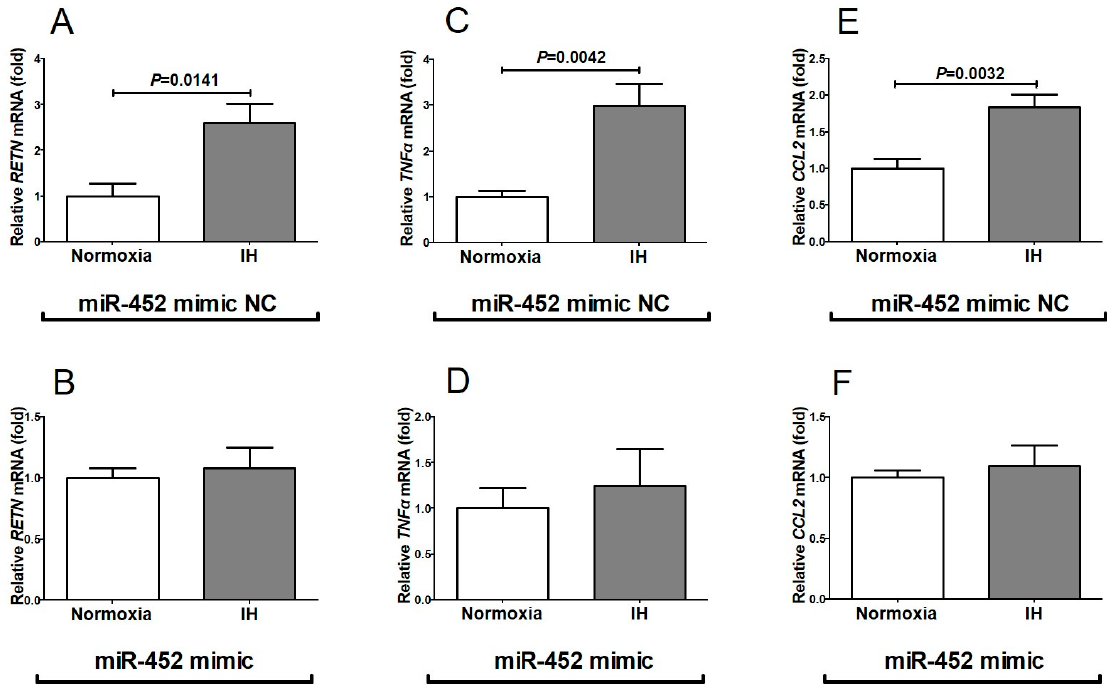
Figure 7. Effects of miR-452 mimic transfection on RETN , TNF α , and CCL2 expression. The miR-452 mimic (5 ′ -AACUGUUUGCAGAGGAAACUG-3 ′ , 5 ′ -GUUUCCUCUCUGCAAACAGUUUU-3 ′ ) and non-specific control RNA (miR-452 mimic NC) (5 ′ -UUCUCCGAACGUGUCACGUtt-3 ′ , 5 ′ -ACGUGACACGUUCGGAGAAtt-3 ′ ) were synthesized by Nihon Gene Research Laboratories, Inc. (NGRL; Sendai, Japan) and introduced into SW872 cells using Lipofectamine ® RNAiMAX just before IH/normoxia exposure, and the mRNA levels of RETN , TNF α , and CCL2 were measured by real-time RT-PCR, as described in Materials and Methods. The expression of RETN , TNF α , and CCL2 mRNA was measured by real-time RT-PCR using β -actin as an endogenous control. Figure represents ( A ) RETN mRNA expression in miR-452 mimic NC-introduced cells, ( B ) RETN mRNA expression in miR-452 mimic-introduced cells, ( C ) TNF α mRNA expression in miR-452 mimic NC-introduced cells, ( D ) TNF α mRNA expression in miR-452 mimic-introduced cells, ( E ) CCL2 mRNA expression in miR-452 mimic NC-introduced cells, and ( F ) CCL2 mRNA expression in miR-452 mimic-introduced cells. Data are expressed as mean ± SE for each group ( n = 6). The statistical analyses were performed using Student’s t -test.